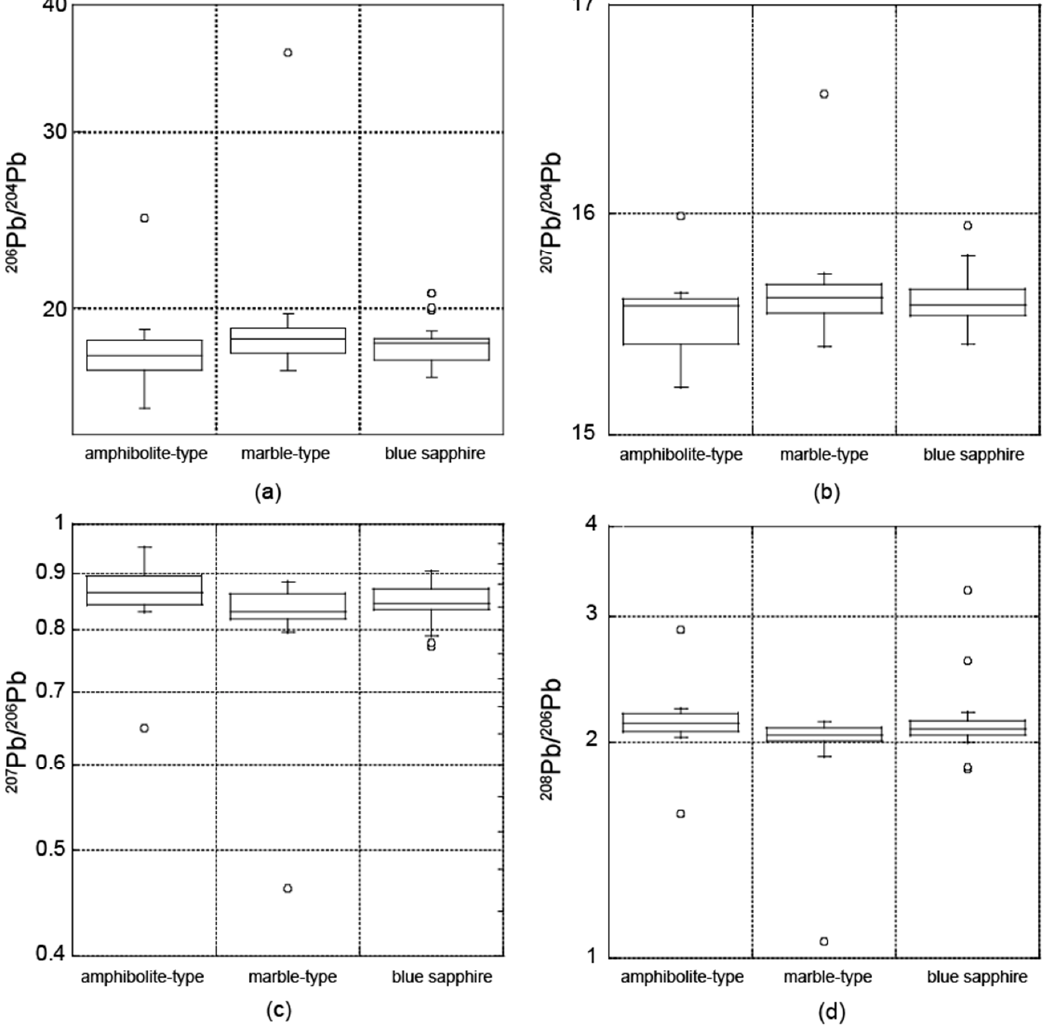
Figure 8. Box and whisker plots displaying ( a ) 206 Pb/ 204 Pb, ( b ) 207 Pb/ 204 Pb, ( c ) 207 Pb/ 206 Pb, and ( d ) 208 Pb/ 206 Pb isotopic compositions of gem corundum from the three different deposit groups measured in this study. Individual data points are outliers whose value is either greater than UQ + 1.5 × IQD or less than LQ − 1.5 × IQD.